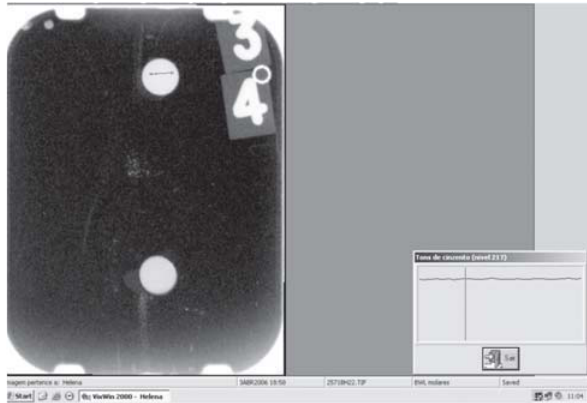
Different letters indicate statistically significant difference at 1%.